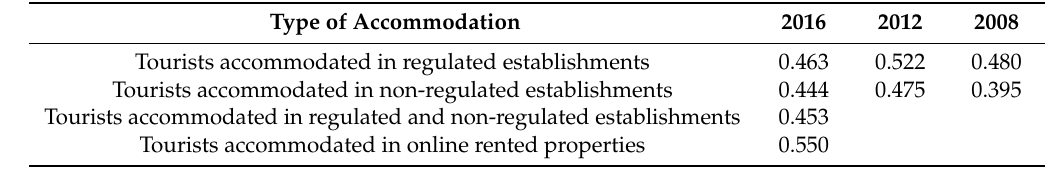
Table 4. Gini Index of the monthly tourist arrivals to the Balearic Islands. Calculated by type of accommodation. Years 2008, 2012 and